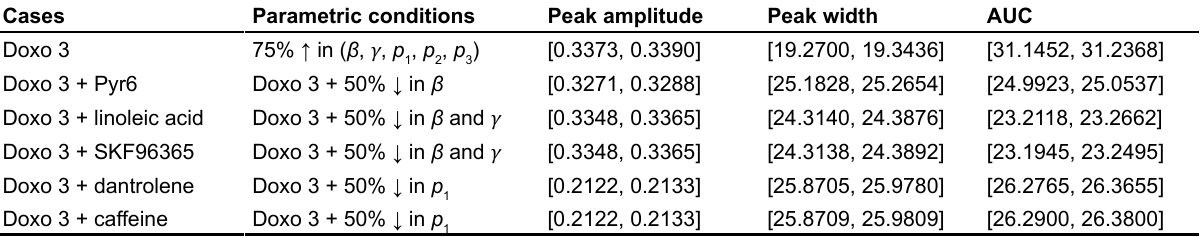
Table 6. 90% CI for Doxo 3 and Doxo 3 + drug parametric conditions